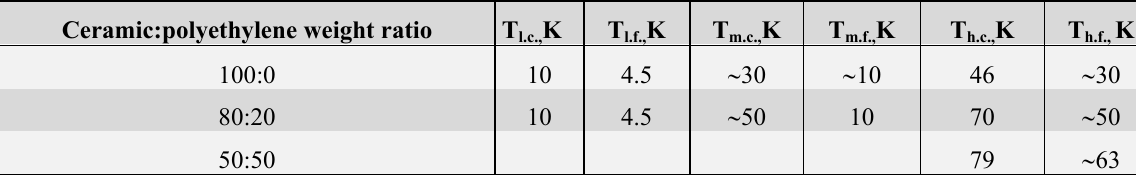
Table 11. Dependence of the critical temperatures of transition into super conducting state and the width of ( T – T ) on the weight ratio of the ceramic and polyethylene. c f Ceramic:polyethylene weight ratio T K T l.c., l.f.,